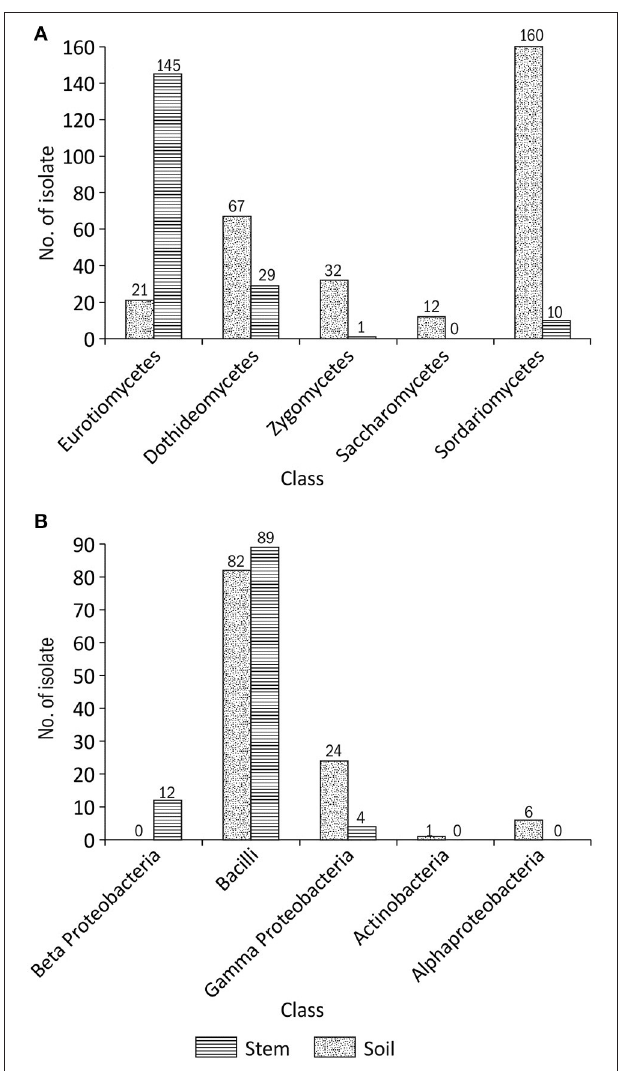
FIGURE 1 | Diversity of fungal (A) and bacterial (B) isolates in the stem and soil samples of Aquilaria malaccensis